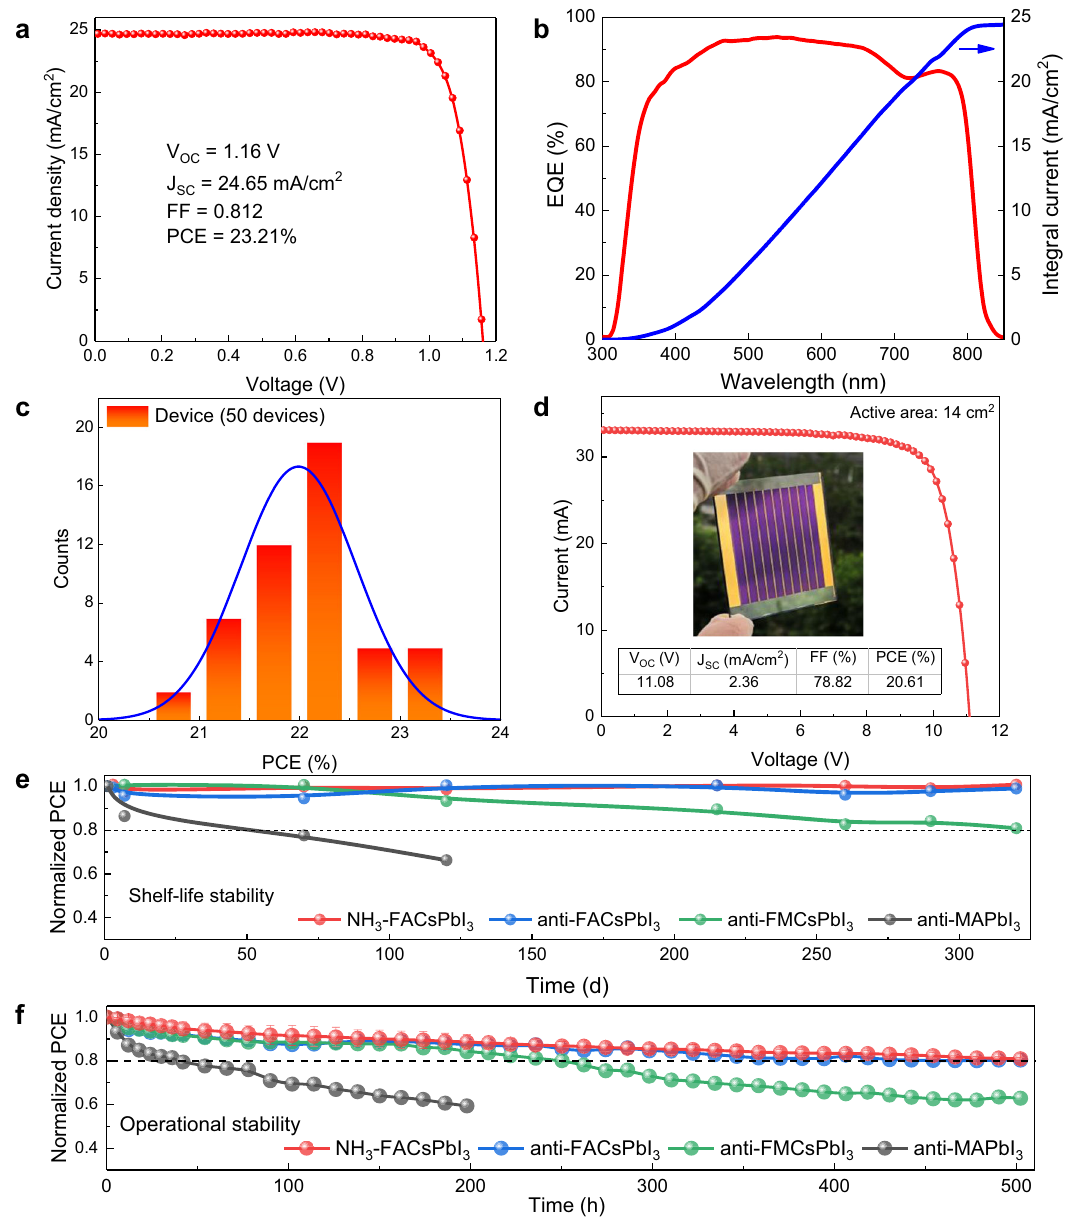
Fig.4|Deviceperformanceandstability.a Currentdensity – voltage( J-V )curveof the champion PSCs based on NH 3 -FACsPbI 3 . b External quantum ef fi ciency (EQE, red) and the integrated short-circuit current density (blue) of the champion NH 3 - FACsPbI 3 device. c Histogram of the power conversion ef fi ciency for 50 NH 3 - FACsPbI 3 PSCs. d J-V curve of NH 3 -FACsPbI 3 PSC module. e Normalized power conversion ef fi ciency (PCE) of unencapsulated NH 3 -FACsPbI 3 , anti-FACsPbI 3 ,